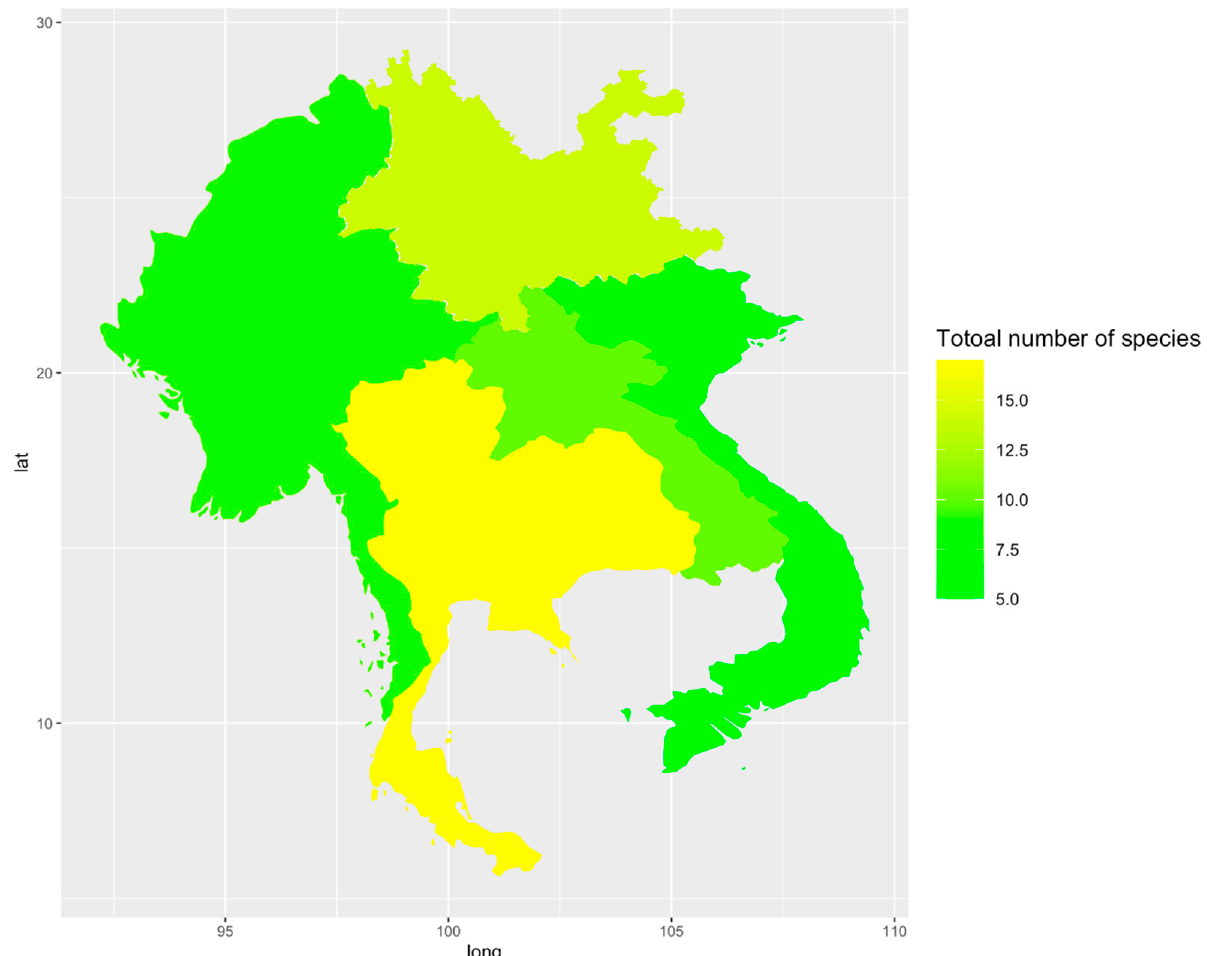
Figure 2. Species diversity (SD) hotspots of Ganoderma species in the GMS.